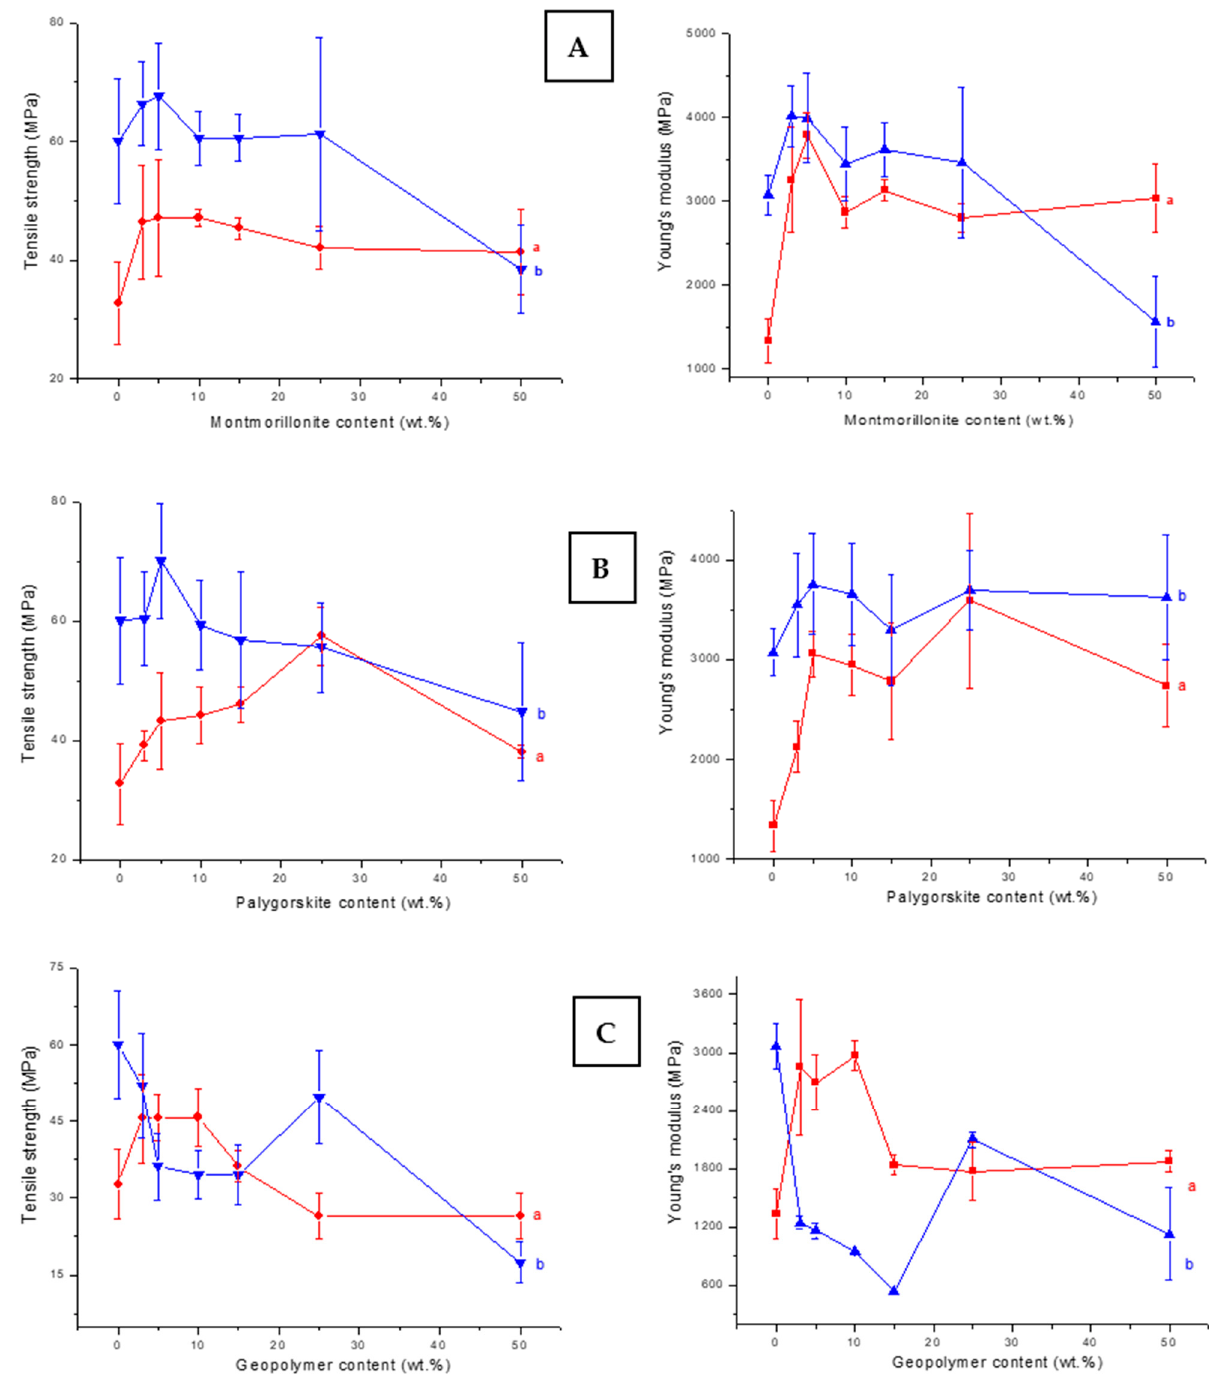
Figure 1. Variations in tensile strength and Young’s modulus of films prepared as a function of the fillers additions. ( a ) ( α -chitosan)-based films. ( b ) ( β -chitosan)-based films. ( A ) montmorillonite-, ( B ) palygorskite-, and ( C ) GCM-containing films.